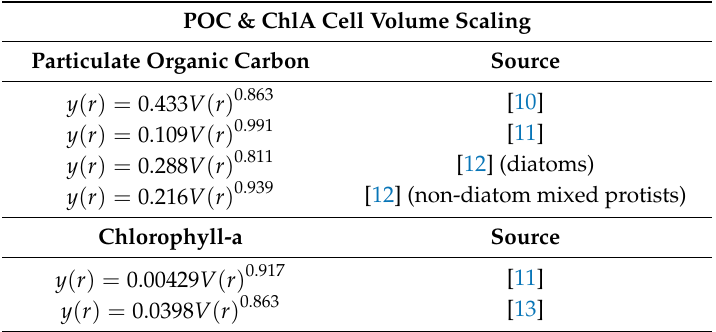
Table 2. Particulate organic carbon and chlorophyll-a cell volume scaling models used in this